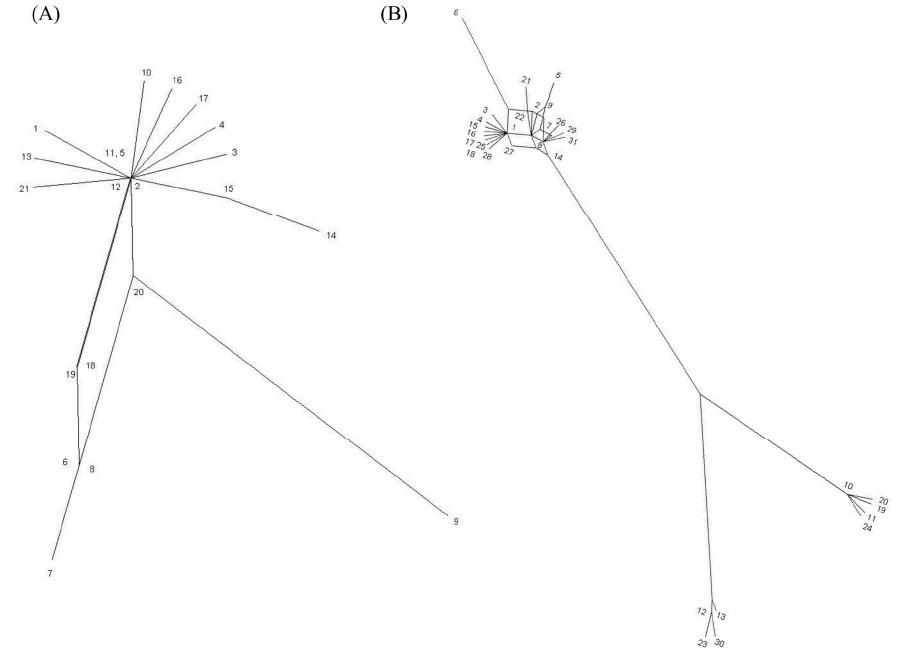
Figure 3. Split decomposition analysis of all current recA (A) and tly (B) allele sequences . recA allele sequences (753 bp) were taken from the MLST 9 database (http://pacnes.mlst.net/) and tly allele sequences (777 bp) from the MLST 8 database (https://pubmlst.org/pacnes/); the latter is updated from [12] with new allele sequences. No evidence of statistically significant recombination was identified in either genes using the Phi test (p=0.135 for recA ; p=0.735 for tly ), although some interconnected pathways were present.